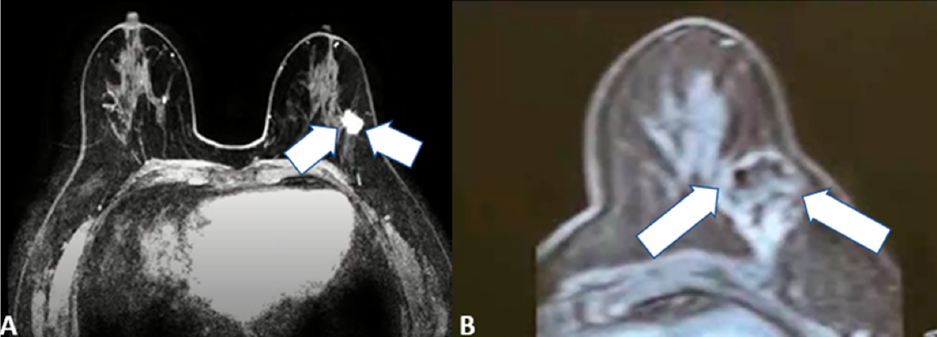
Figure 5. 64-year-old female patient with left invasive T1 breast cancer of 11 mm with a molecular subtype Luminal-A. Contrast-enhanced T1-weighted MRI scan showing ( A ) baseline neoplastic lesion and ( B ) 5-month follow-up after microwave ablation with good ablation margins and central necrosis.